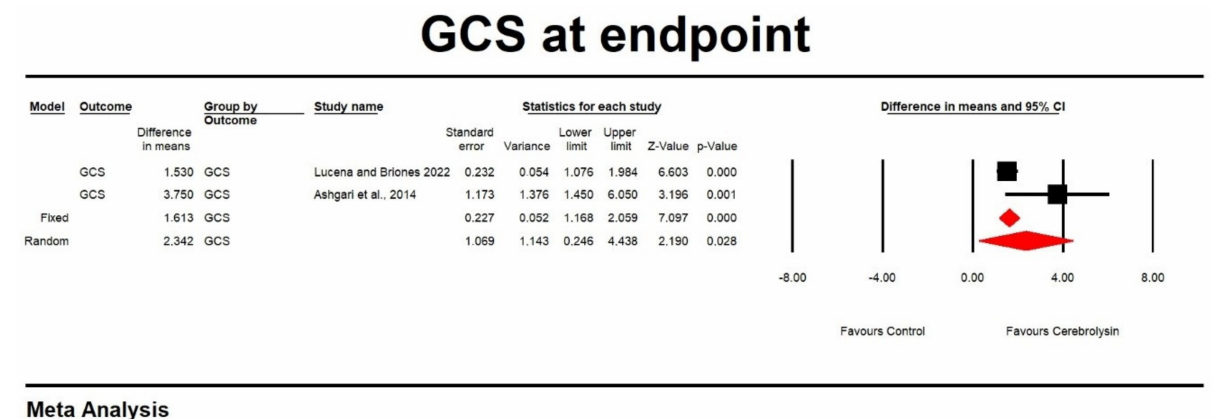
Figure 2. Effect of Cerebrolysin on GCS score (Z value = 2.190, p = 0.028). [21,26].